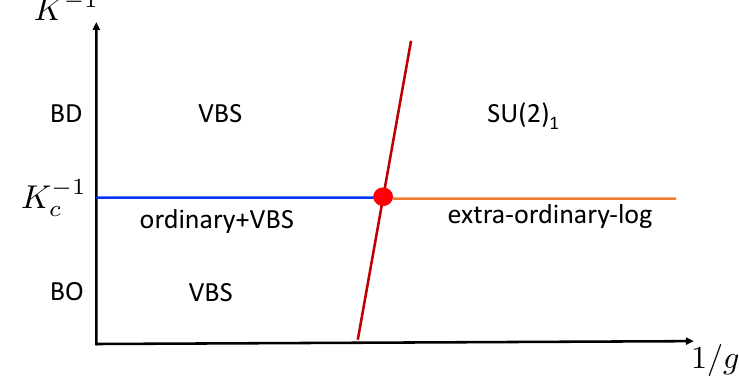
Figure 10: A possible phase diagram for the 2 + 1D spin S = 1 / 2 model with a “dan- gling"